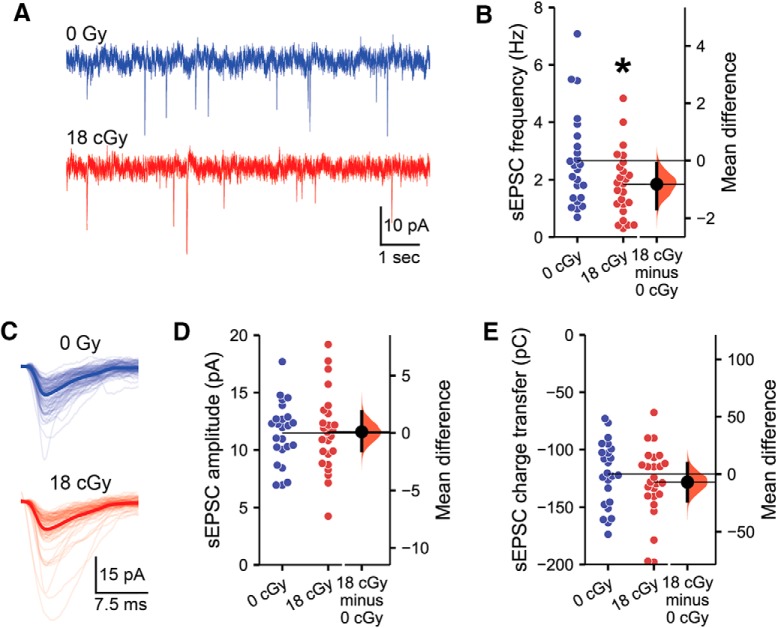
Excitatory synaptic signaling to CA1 pyramidal neurons is decreased following neutron irradiation. All data are from whole-cell recordings of CA1 pyramidal neurons from the superficial layer of the dorsal hippocampus voltage-clamp at −65 mV, 6 months following the completion of 18 cGy neutron irradiation. A, Representative examples of recordings containing spontaneous EPSCs from neurons from neutron-irradiated animals. B, sEPSCs were less frequent in neurons from neutron-irradiated animals. C, Examples of EPSCs in representative neurons from neutron-irradiated animals. Light lines show individual sEPSCs, whereas the darker line displays the average sEPSC during a 200 s recording from that neuron. Neither the sEPSC amplitude (D) nor sEPSC charge transfer (E) was altered by neutron irradiation. N = 8/7 animals, 24/25 cells (0 cGy and 18 cGy, respectively). Gardner–Altman estimation plots show raw data on the left axis and a bootstrapped sampling distribution on the right axis. A black dot depicts the mean difference between groups and the 95% CI is indicated by the ends of the vertical black bars. *p < 0.05 (MLM regression).